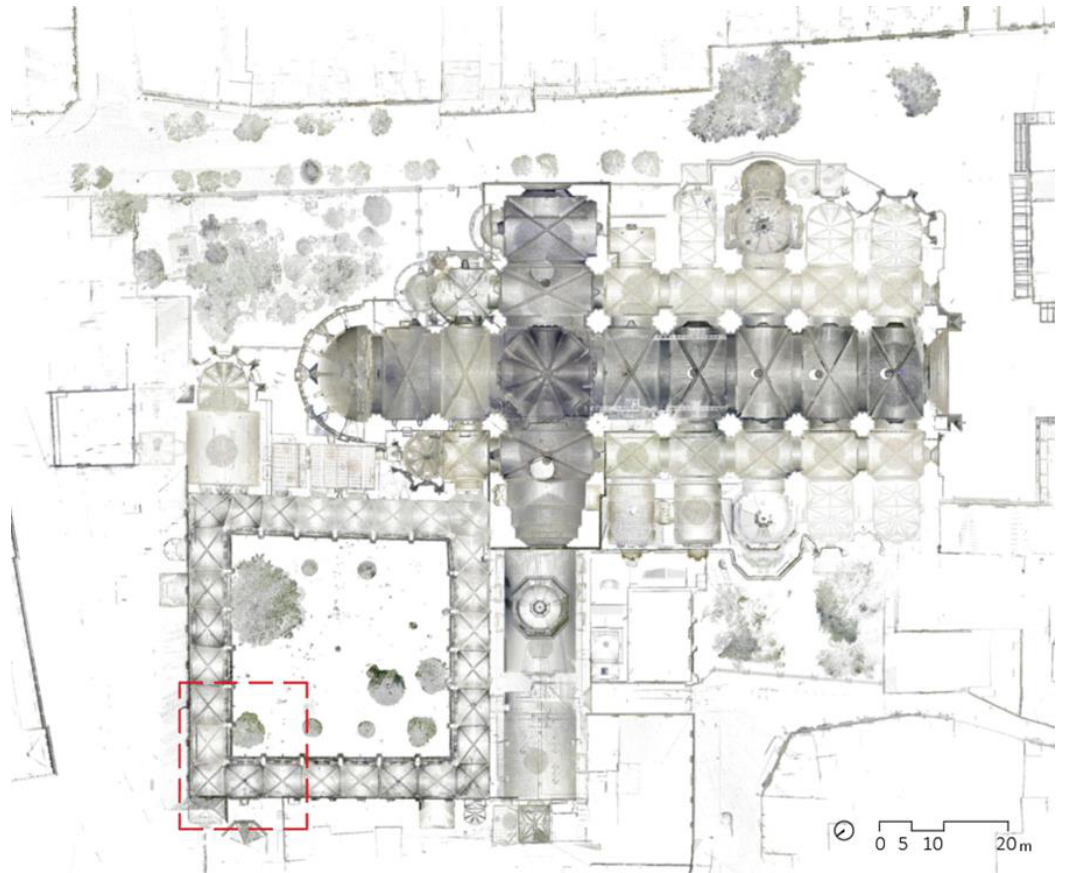
Figure 1. Ground floor of the Cathedral of Tarragona and the studied cloister corner.